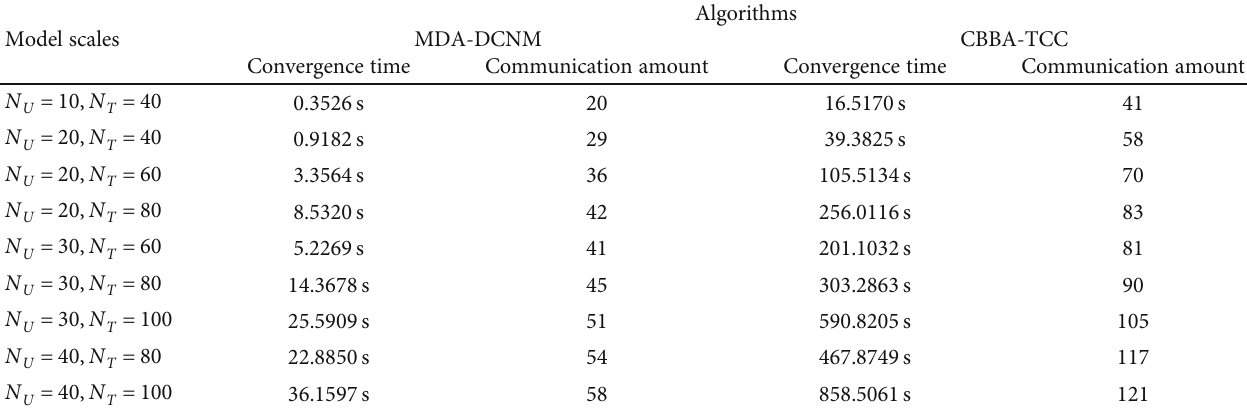
Table 10: Convergence performance of two algorithms under di ff erent model scales.